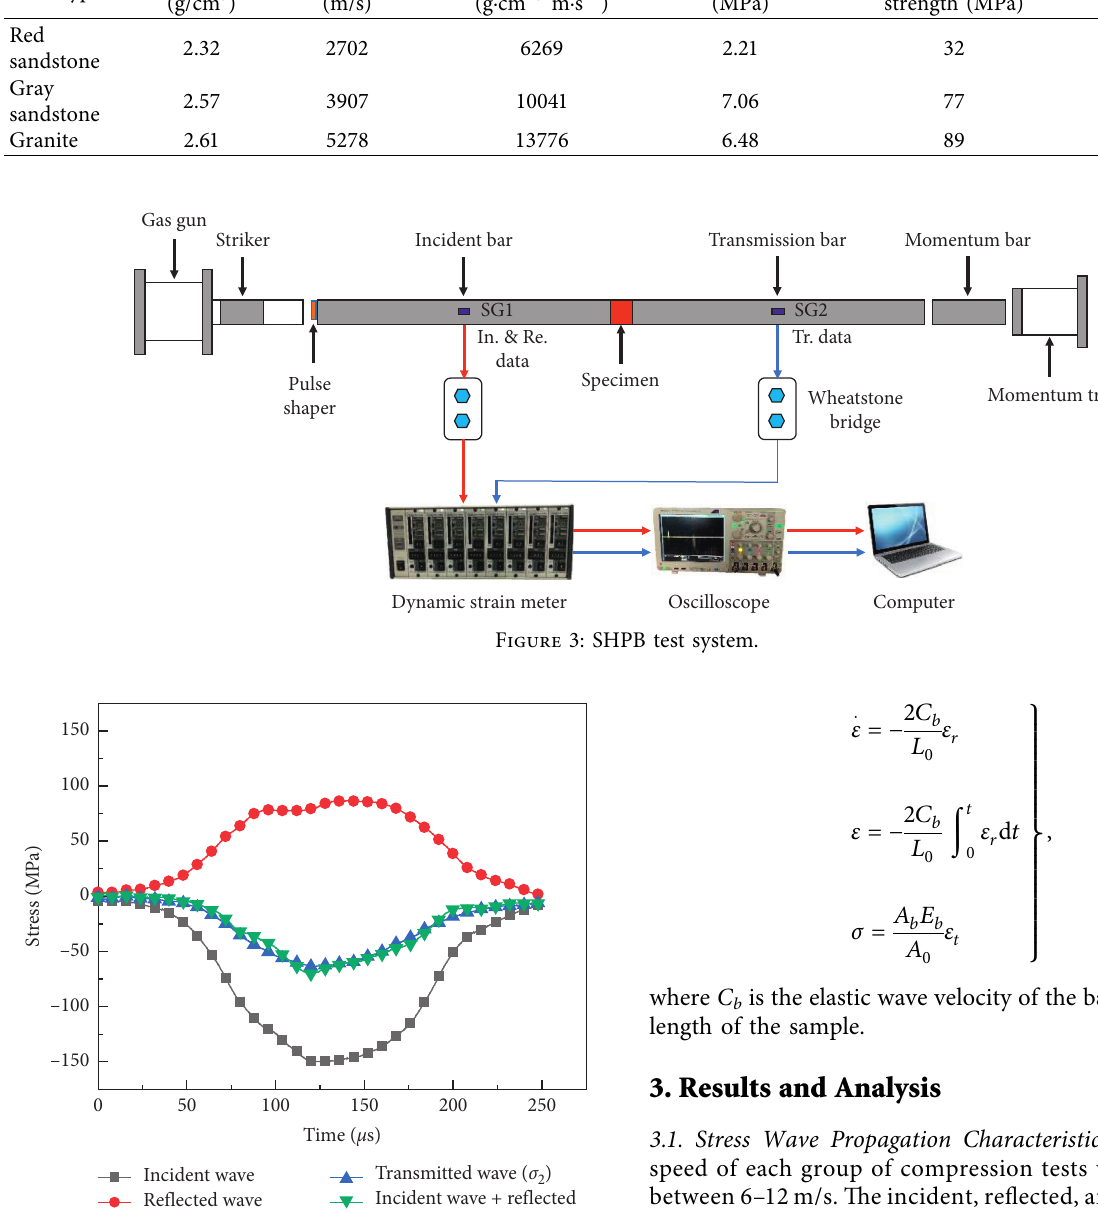
Figure 4: Verification of dynamic stress balance for typical